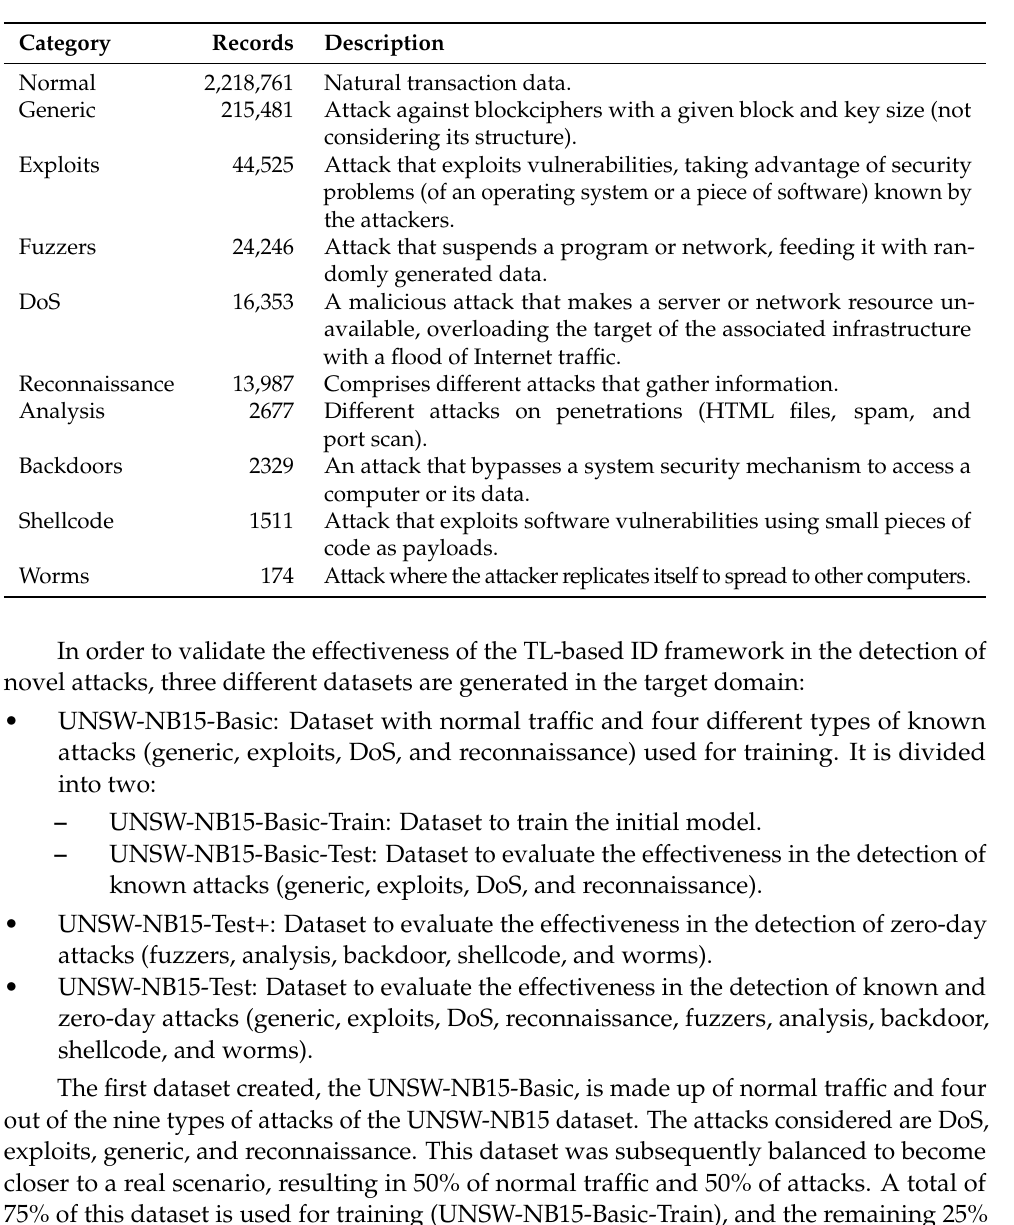
Table 3. UNSW-NB15